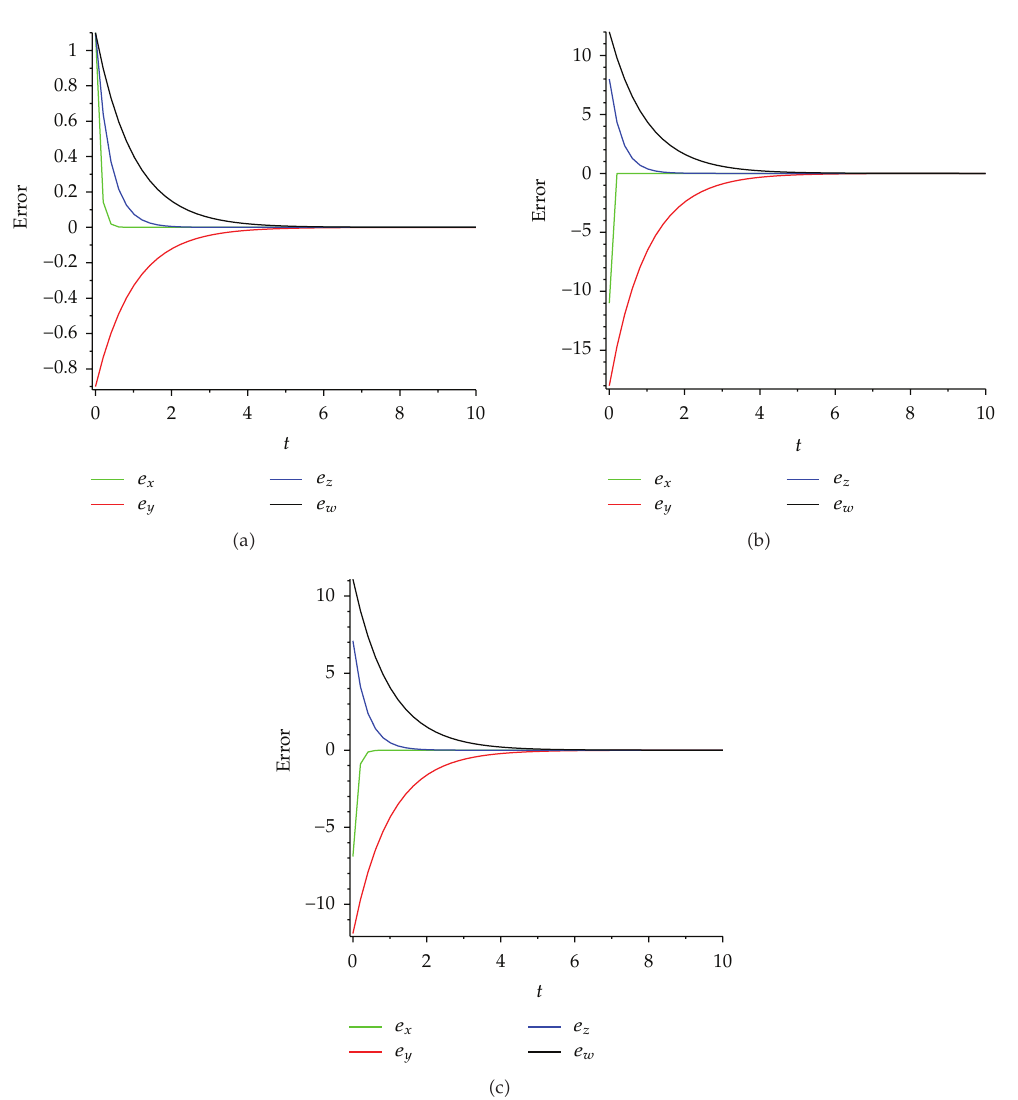
Figure 16: (cid:6) a (cid:7) Its shows the behaviour of the trajectories e x ,e y ,e z , and e w of the hyperchaotic Lorenz system error system tends to zero as t tends to 5 when the scaling factor α (cid:8) − 1. (cid:6) b (cid:7) It shows that the behaviour of the trajectories e x ,e y ,e z , and e w of the hyperchaotic L¨u system error system tends to zero as t tends to 5 when the scaling factor α (cid:8) − 1. (cid:6) c (cid:7) It shows that the behaviour of the trajectories e x ,e y ,e z , and e w of the error system between hyperchaotic Lorenz system and hyperchaotic L¨u system tends to zero as t tends to 5 when the scaling factor α (cid:8) − 1.